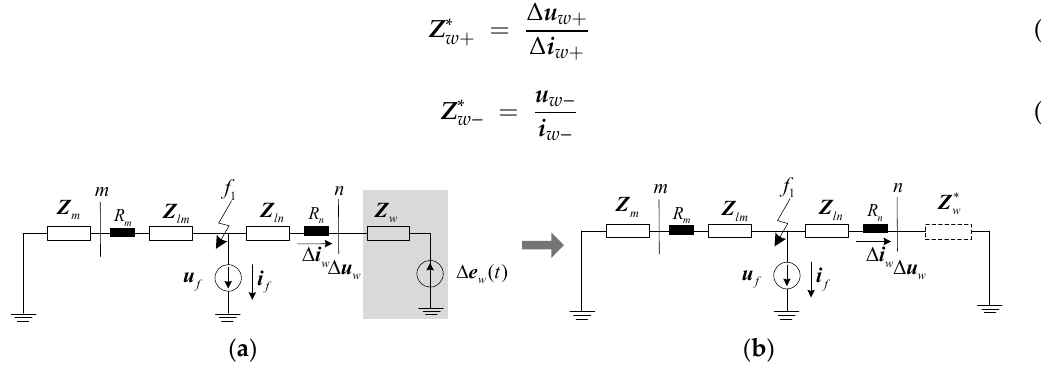
Figure 2. Fault component network and its equivalent network of the transmission line connected to a wind farm: ( a ) fault component network; and ( b ) equivalent